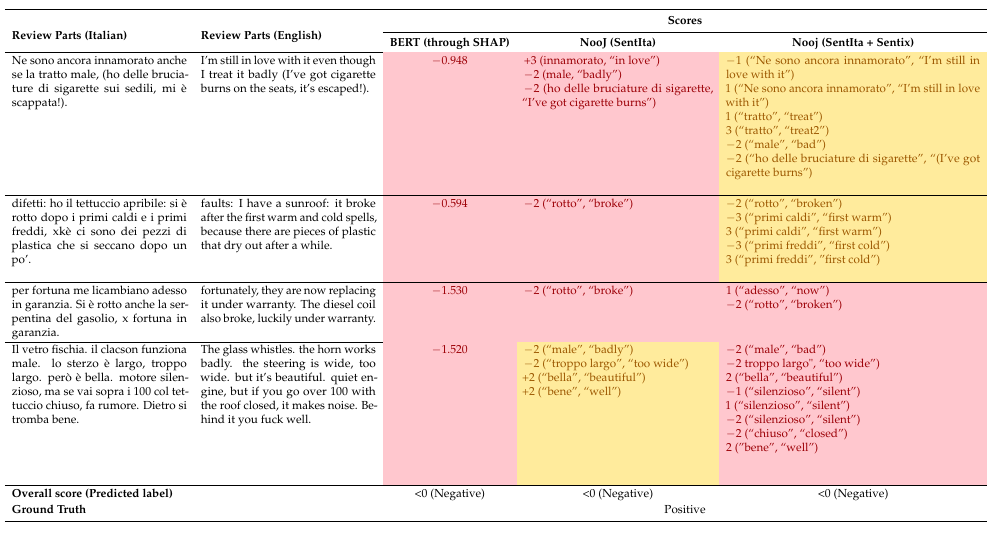
Table 8. Neither BERT nor NooJ detect them correctly. Example